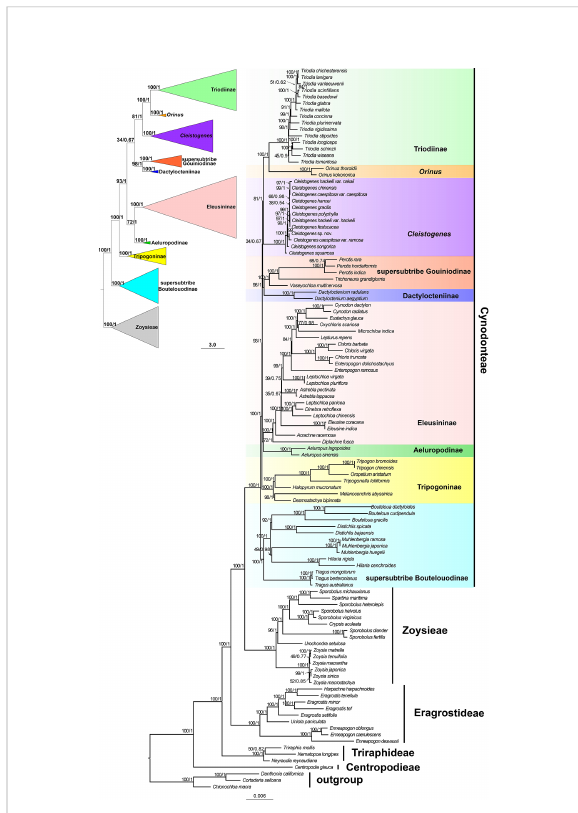
FIGURE 1 Phylogenetic relationships of Chloridoideae inferred from maximum likelihood (ML) and Bayesian inference (BI) based on 111 complete plastomes (excluding one copy of the inverted repeat (IR)). Support values marked above the branches follow the order bootstrap value (BS)/posterior probability